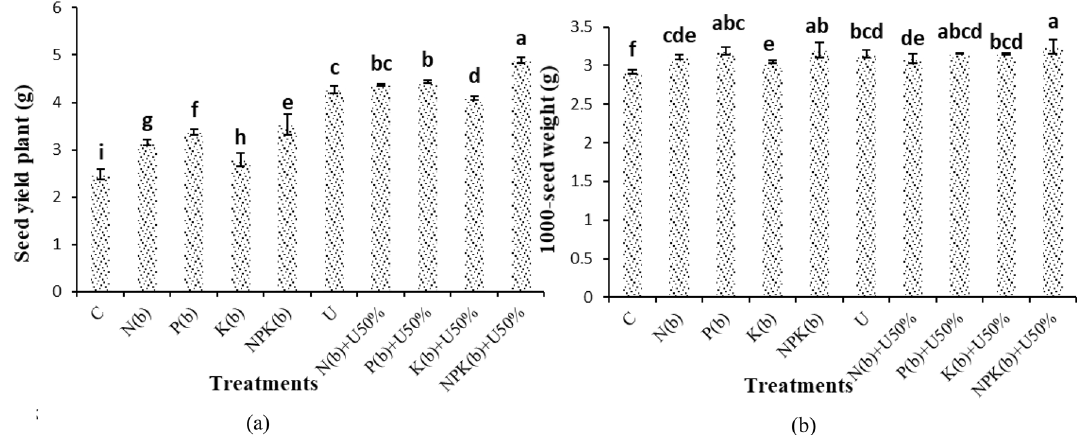
Figure 3. Means comparison for seed yield per plant and 1000-seed weight of Nigella sativa L. as influenced by biofertilizers and urea. Dissimilar letters show significant differences at the p ≤ 0.01 level. Control (C),